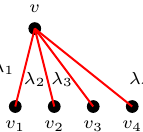
Figure 3.2: Component of a good graph with the label on the